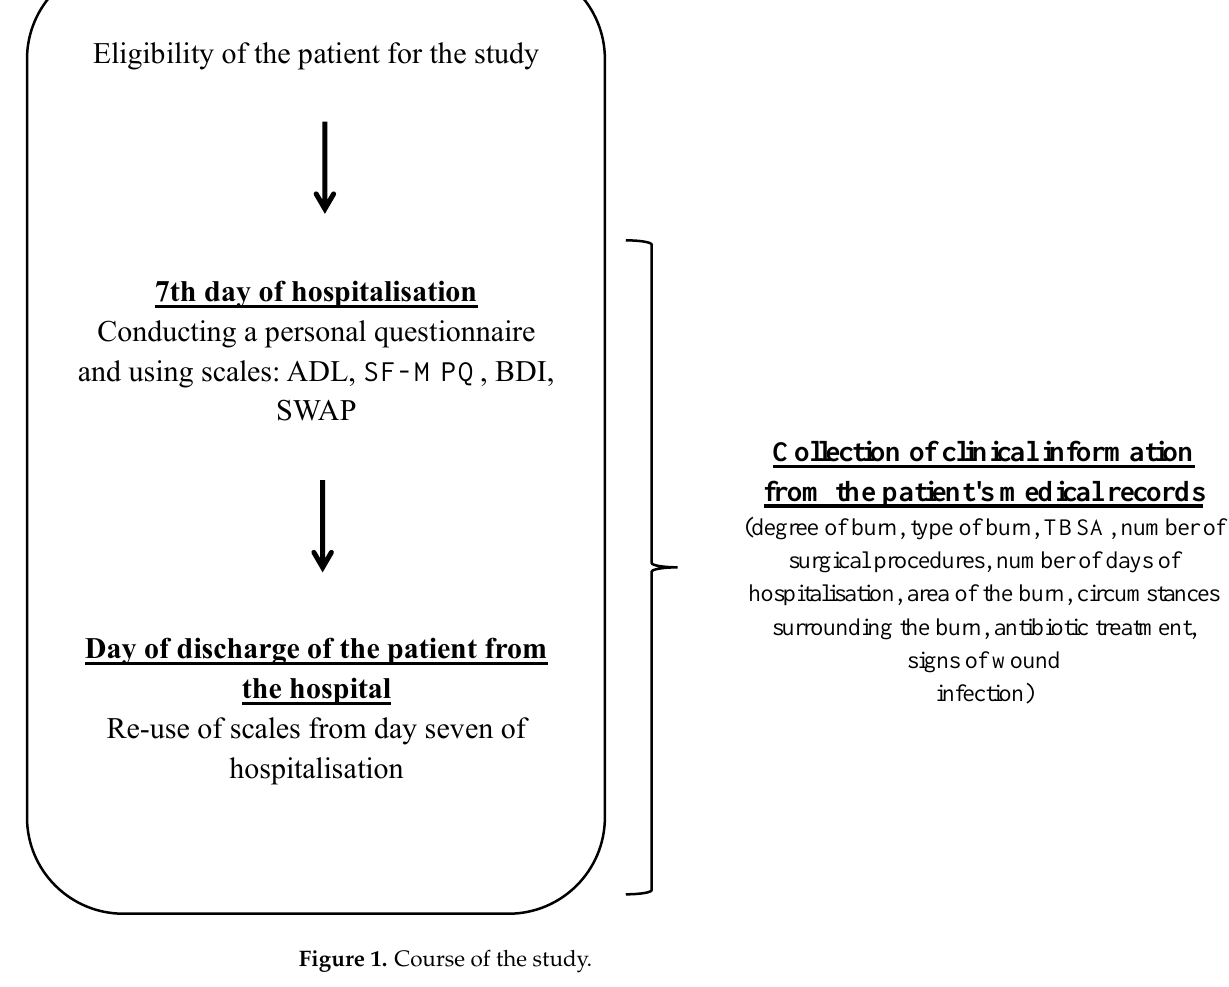
Figure 1. Course of the